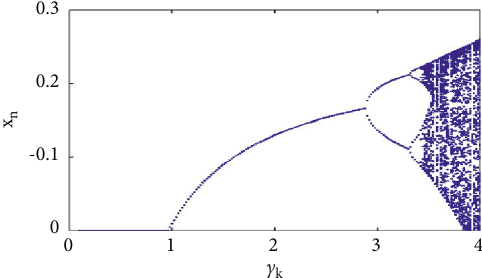
Figure 4: Bifurcation diagram of system (32) by using x